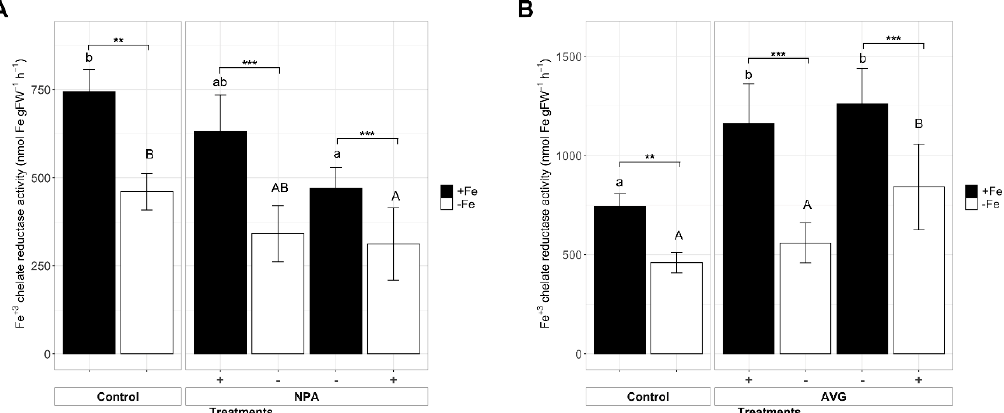
Figure 4. Iron (Fe 3+ )-chelate reductase activity (FCR): ( A ) FCR activity in split-root tomato plants both not-supplemented and supplemented with polar auxin transport inhibitor NPA; ( B ) FCR activity in split-root tomato plants both not-supplemented and supplemented with ethylene signaling inhibitor AVG. Data are reported as means ± SE of three independent biological replicates (each biological replicate was the mean of five plants) for each treatment. Statistical significance was tested by one-way ANOVA analysis with Tukey post hoc tests ( p < 0.001). Different letters indicate statistically different values. The statistical significance between resupplied and not-resupplied root compartments was tested by Student’s t -test (**, p < 0.01; ***, p < 0.001).